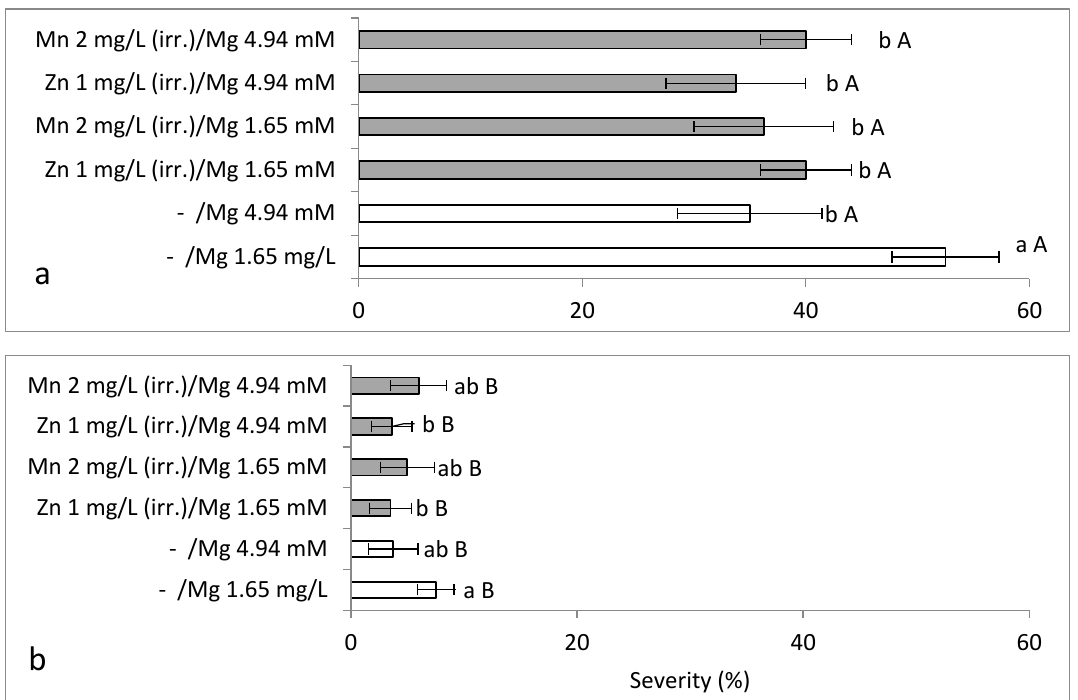
Figure 5. Effects of adding Zn-EDTA (1 mg/L; 1.64 mM) and Mn-EDTA (2 mg/L; 4.94 mM) to the irrigation solution on the